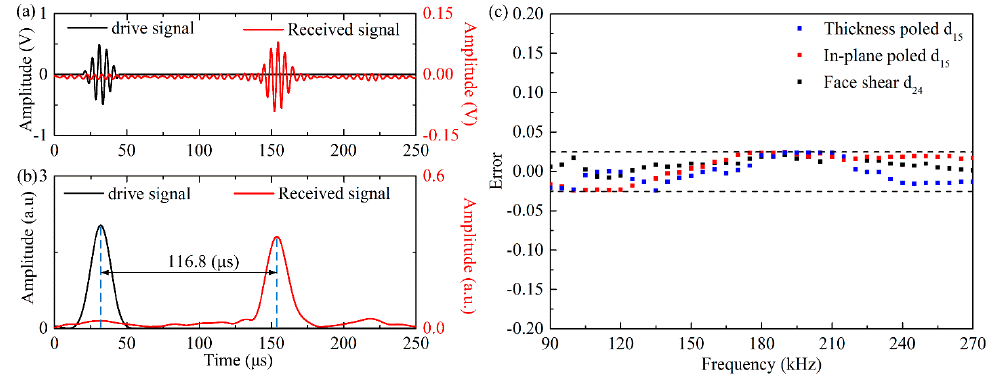
Figure 6. ( a ) Wave signals generated by the d 24 piezoelectric wafer and received by the d 36 type PMN-PT wafer with drive voltage of 20 V at 200 kHz; ( b ) continue wavelet transform (CWT) of the drive signal and receive signal in ( a ); ( c ) Frequency dependent relative errors of the measured group velocity of the SH 0 waves generated by different shear mode piezoelectric wafers